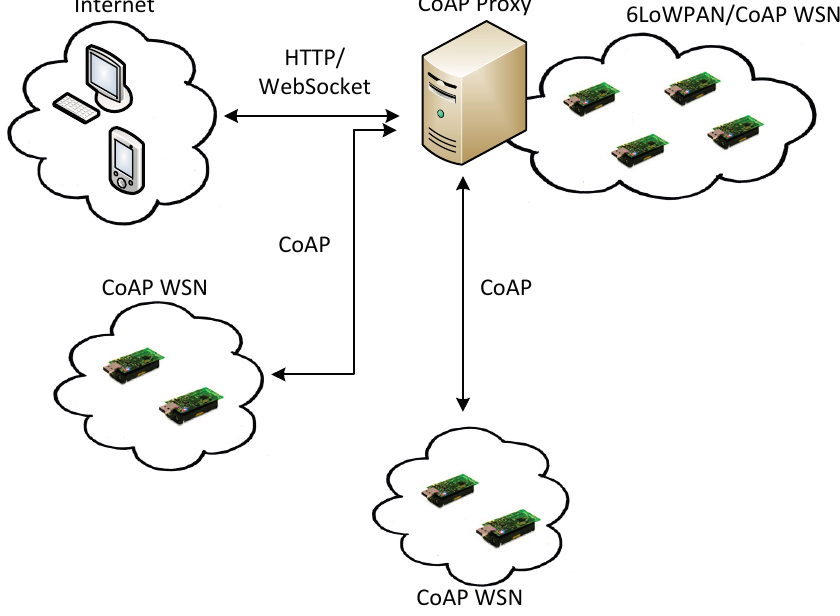
Figure 1. Protocol Stack. The Constrained Application Protocol (CoAP) proxy allows for adapting the protocol stacks of Web applications and CoAP devices.